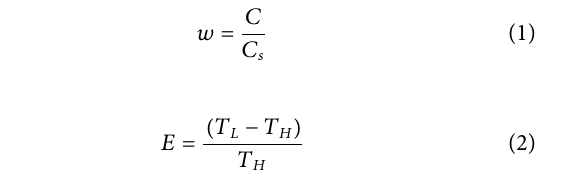
Frontiers in Environmental Science |